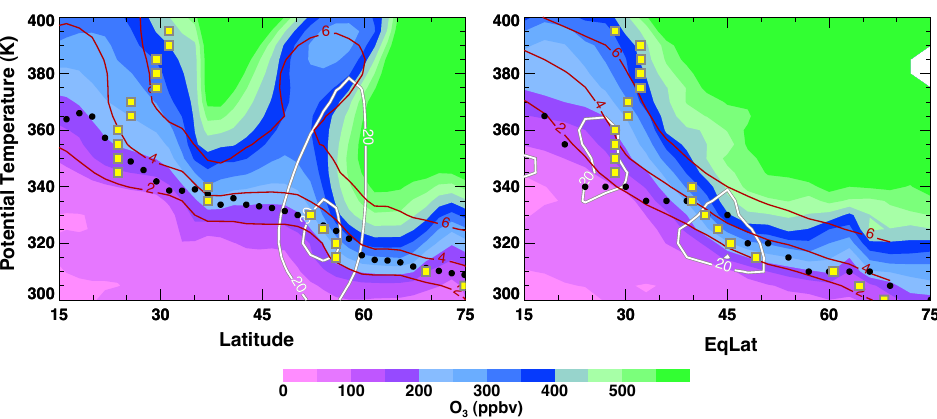
Fig. 12. Sectional zonal means of ozone for 110 ◦ –150 ◦ W in (a) latitude and (b) EqLat. Yellow squares represent the dynamical tropopause at each isentrope. Black dots represent the thermal tropopause. Also shown are PV inpvu (red contours) and zonal wind in ms − 1 (white